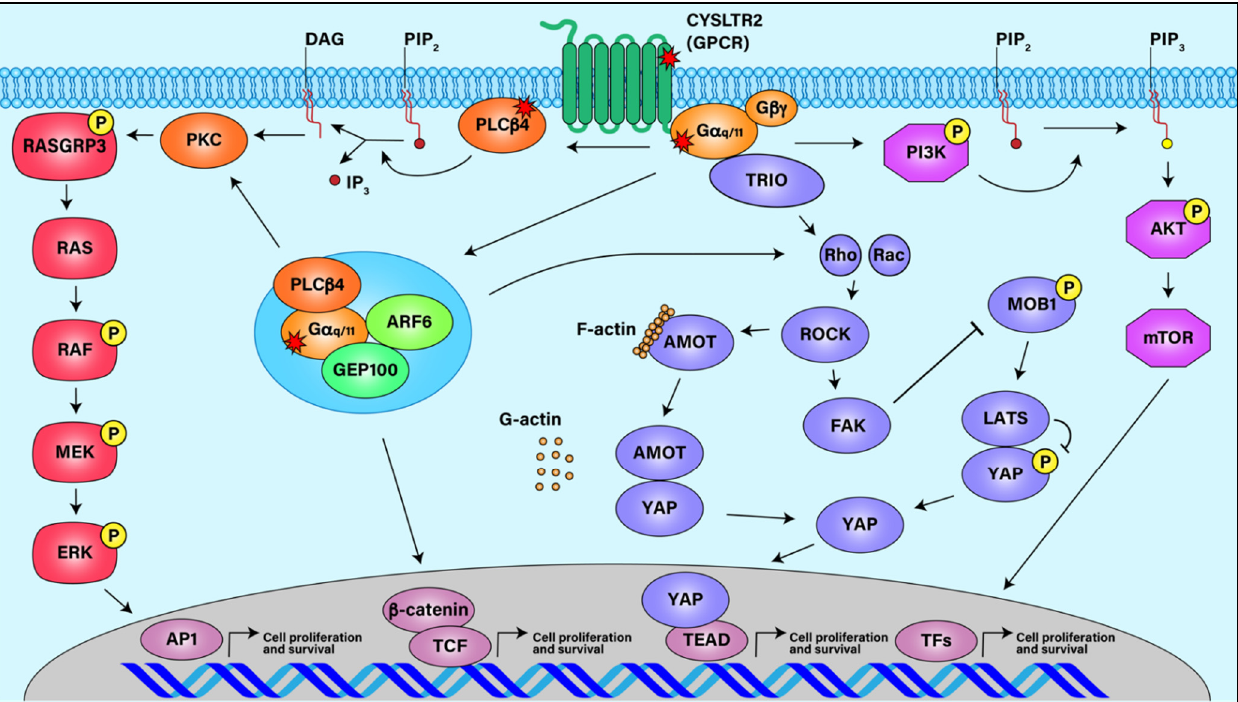
Figure 1. Signaling Pathways in Uveal Melanoma. Activating mutations in GPCR CysLTR2, G α q/11 , and PLC β 4 stimulate downstream signaling pathways such as ARF6, MAPK, FAK/YAP, and AKT/MTOR, all of which can lead to UM cell proliferation and survival.